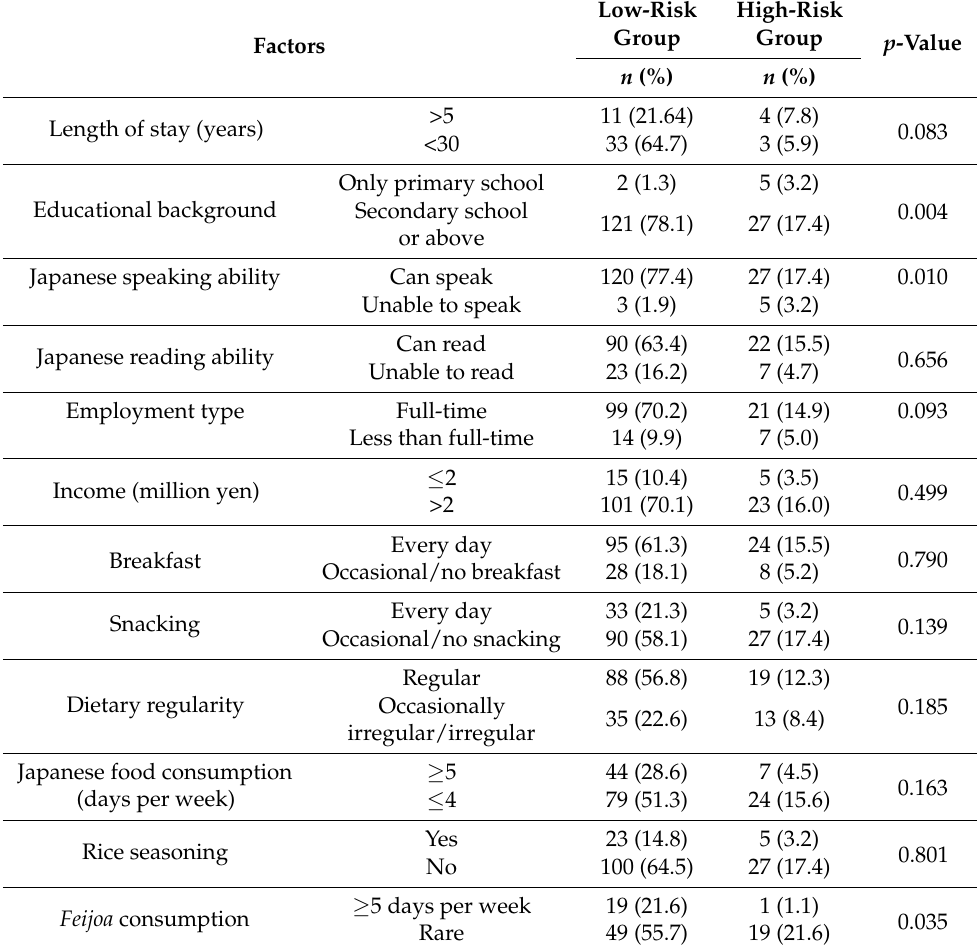
Table 4. Comparison of various factors between the high- and low-risk groups based on FINDRISCs.